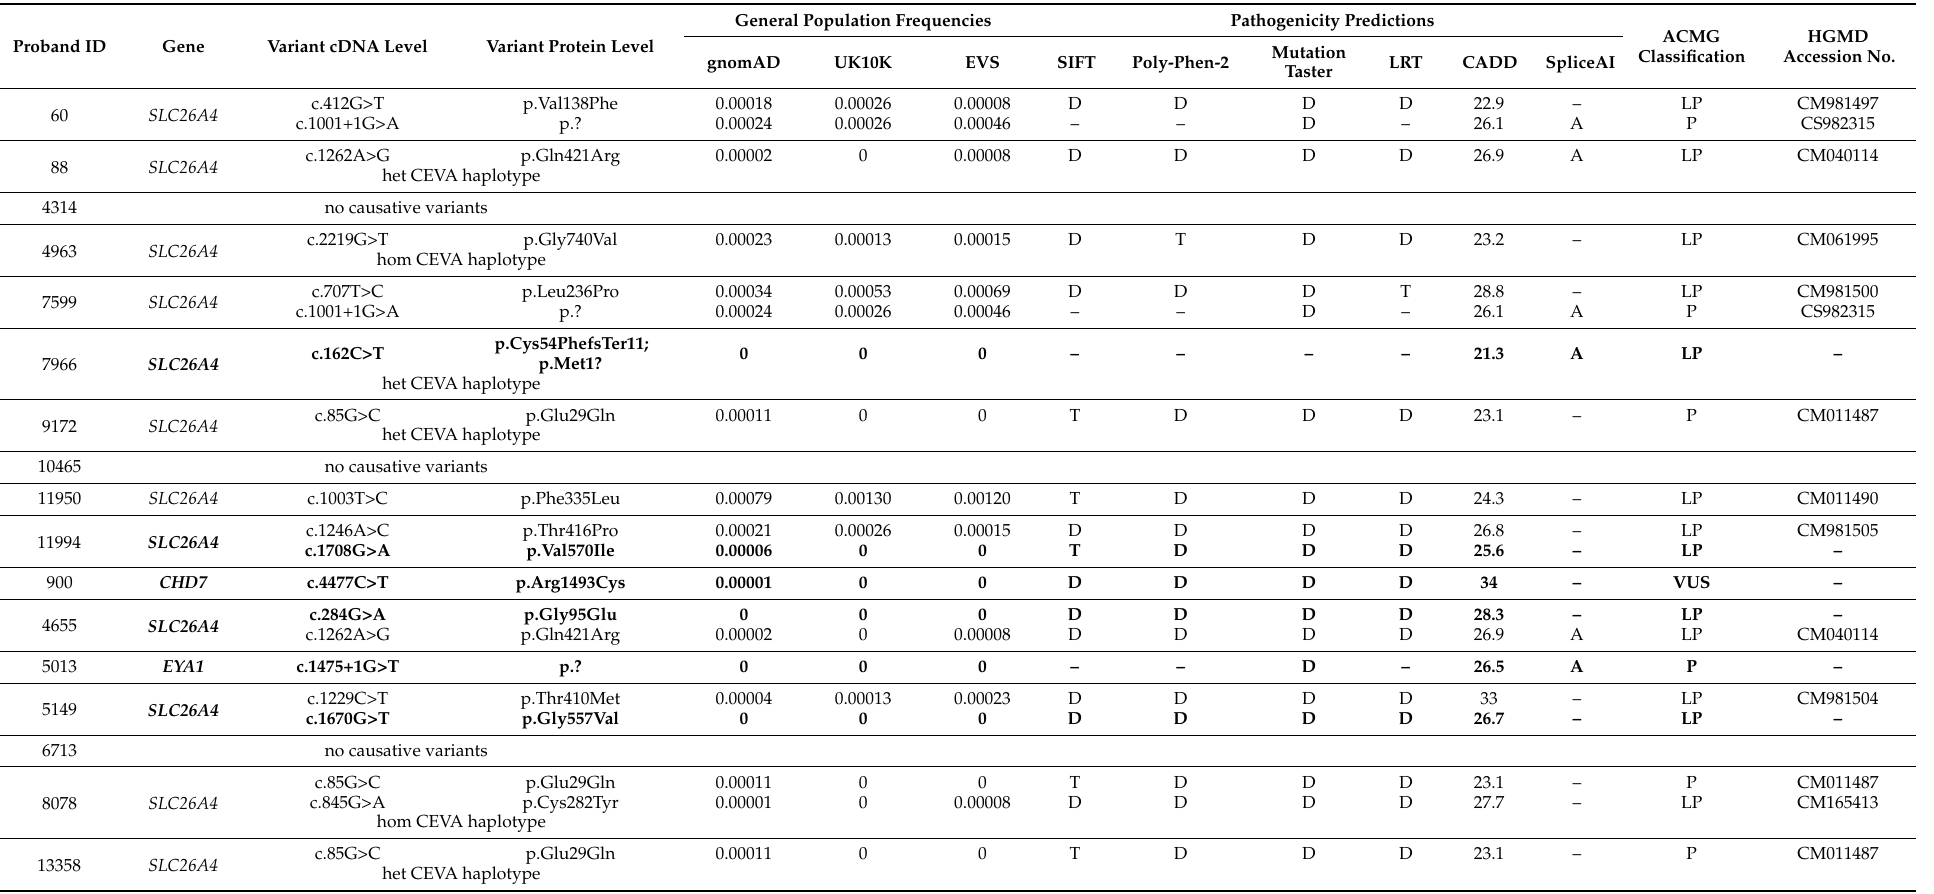
Table 2. List and characteristics of the probably causative variants which were